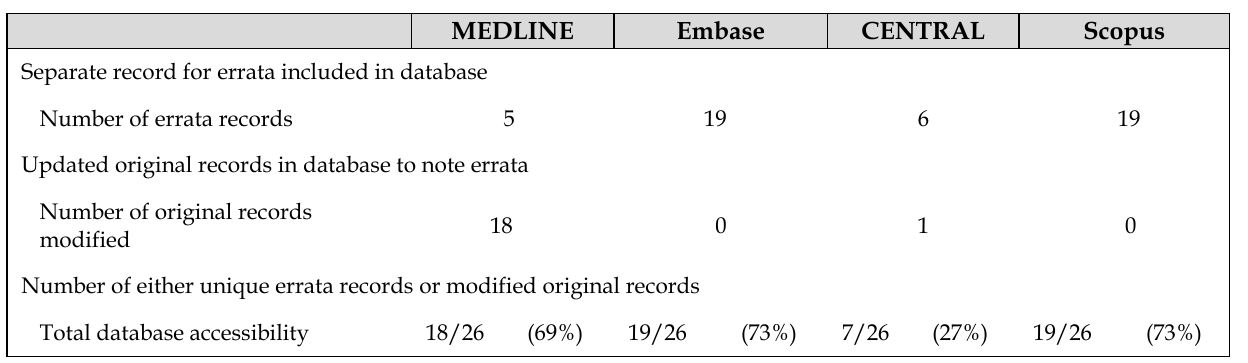
Table 2 Database accessibility of